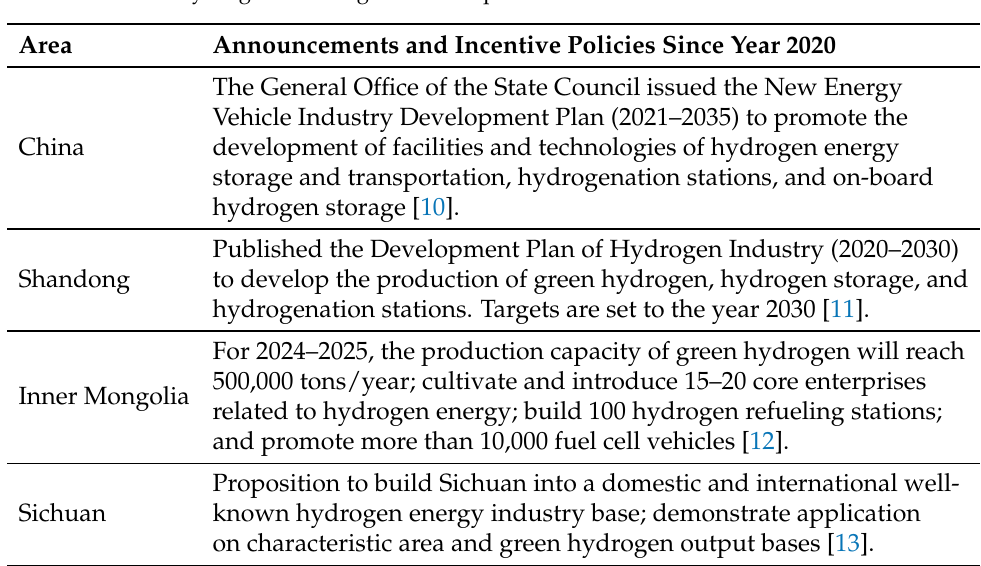
Figure 1. Global hydrogen demand from 1975 to 2018. Table 1. Selected hydrogen-related government policies announced in China since 2020.